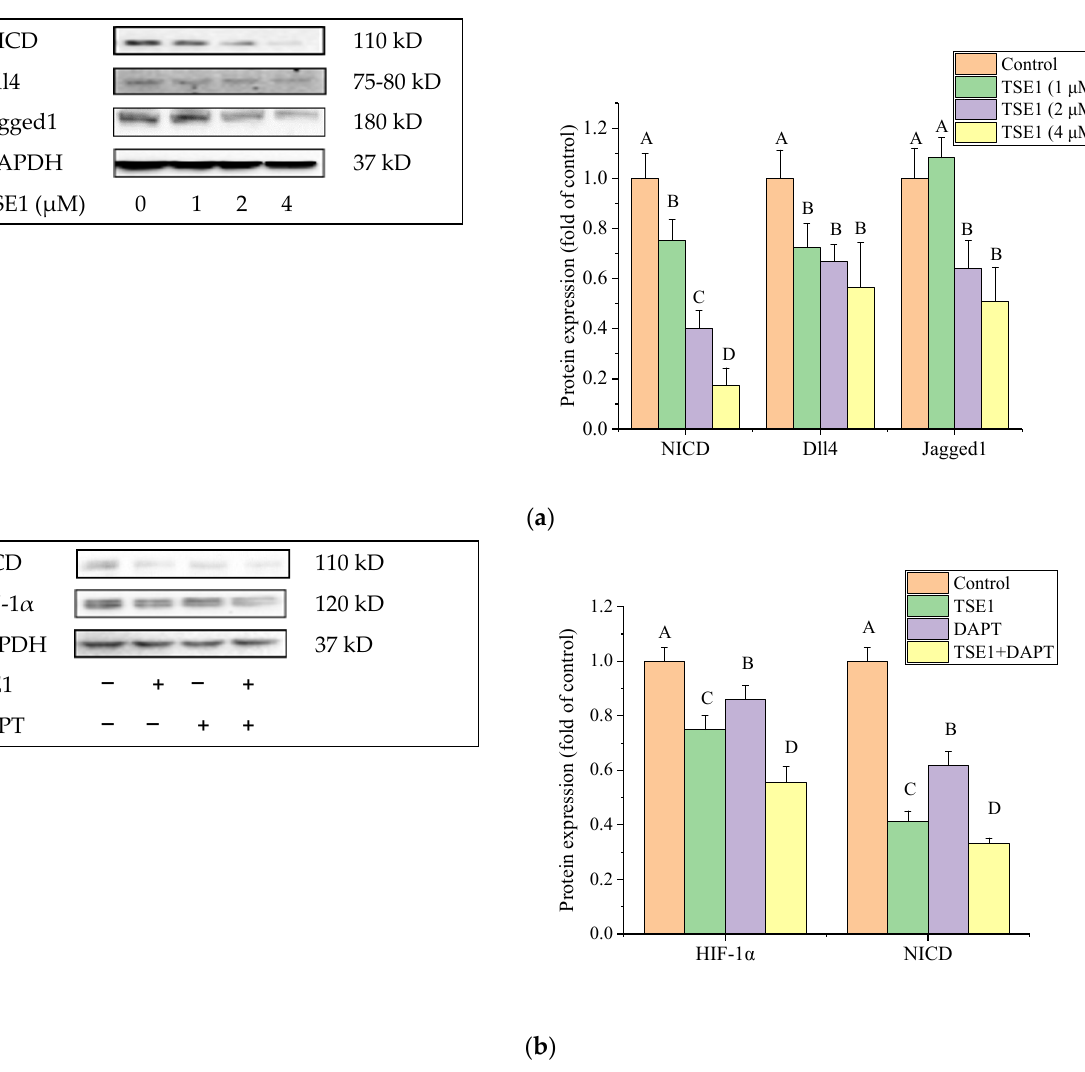
Figure 6. TSE1 regulated Notch1 pathway in OVCAR-3 cells after 24 h treatment. ( a ) Protein expressions of NICD, Dll4 and Jagged1. ( b ) Combination of TSE1 and DAPT enhanced the inhibitory effect on HIF-1 α protein expression. Cells were treated with 2 μ M of TSE1, 80 μ M of DAPT or their combination for 24 h. Protein expression was determined by Western blot. Results were from three independent experiments and were expressed as means ± SD. Significant differences among different treatments are indicated by different letters ( p < 0.05).